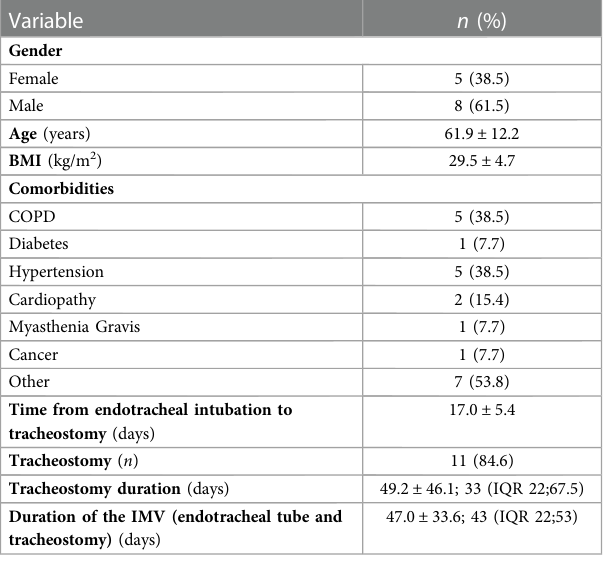
TABLE 1 Demographic and clinical characteristics of the enrolled